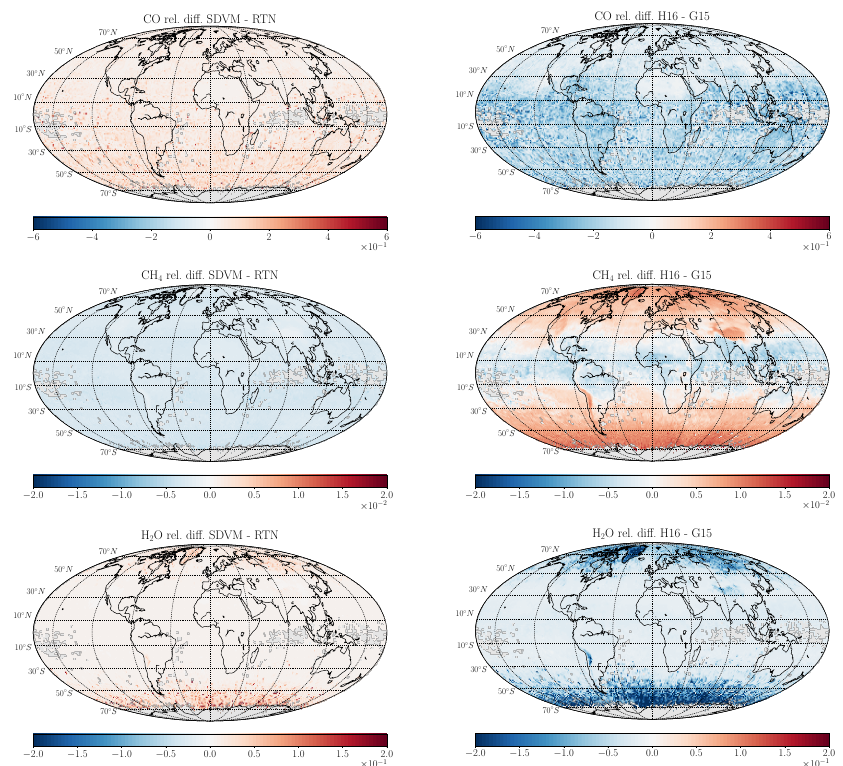
Figure A3. Left column: Global maps of SDVM to Rautian relative difference for CO, CH 4 and H 2 O scaling factors. Right column: The relative difference of the two Voigt